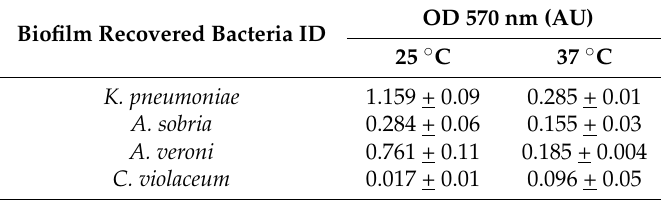
Table 3. Bacteria ability to assemble biofilms in vitro at different temperatures.